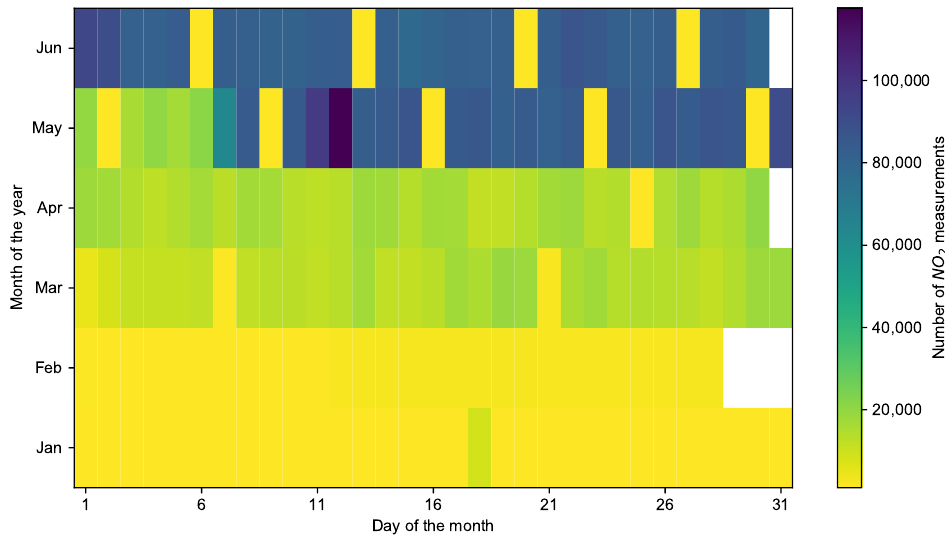
Figure 4. The number of NO 2 measurements collected by all mobile sensors per day from January to June